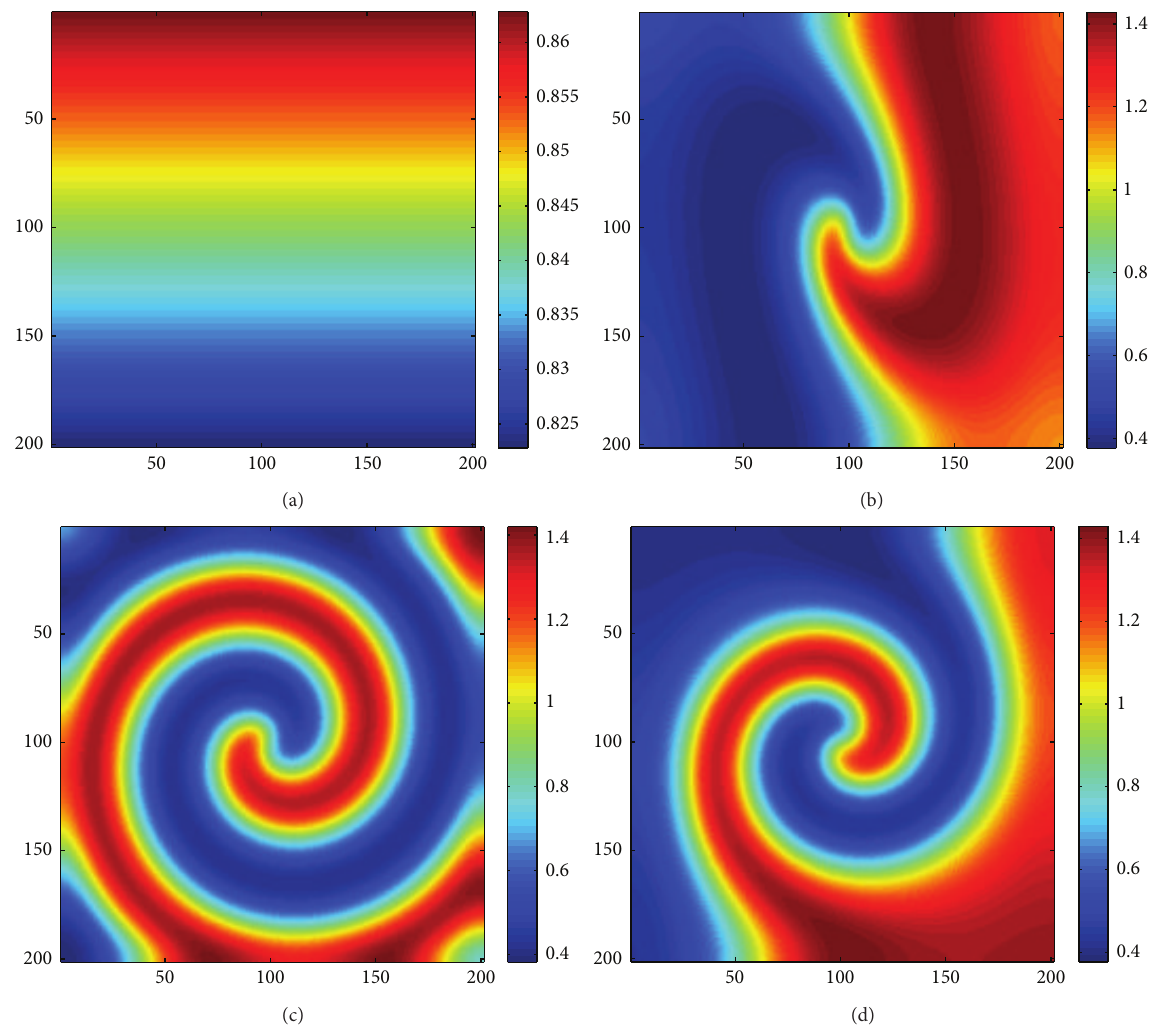
Figure 4: The process of formation of spiral pattern of 𝑢 in model (4) with parameters 𝑎 = 0.43 , 𝑏 = 0.22 , 𝑐 = 0.4 , 𝑟 = 1.4 , 𝑚 = 0.17 , 𝑑 = 0.5 , = 0.4 , 𝑑 = 0.05 , 𝑑 = 0.15 , 𝑑 = 0.37 , and 𝜏 = 0.46 . Times: (a) 𝑡 = 0 , (b) 𝑡 = 500 , (c) 𝑡 = 1500 , and (d) 𝑡 = 3000 𝑑 11 12 21 22